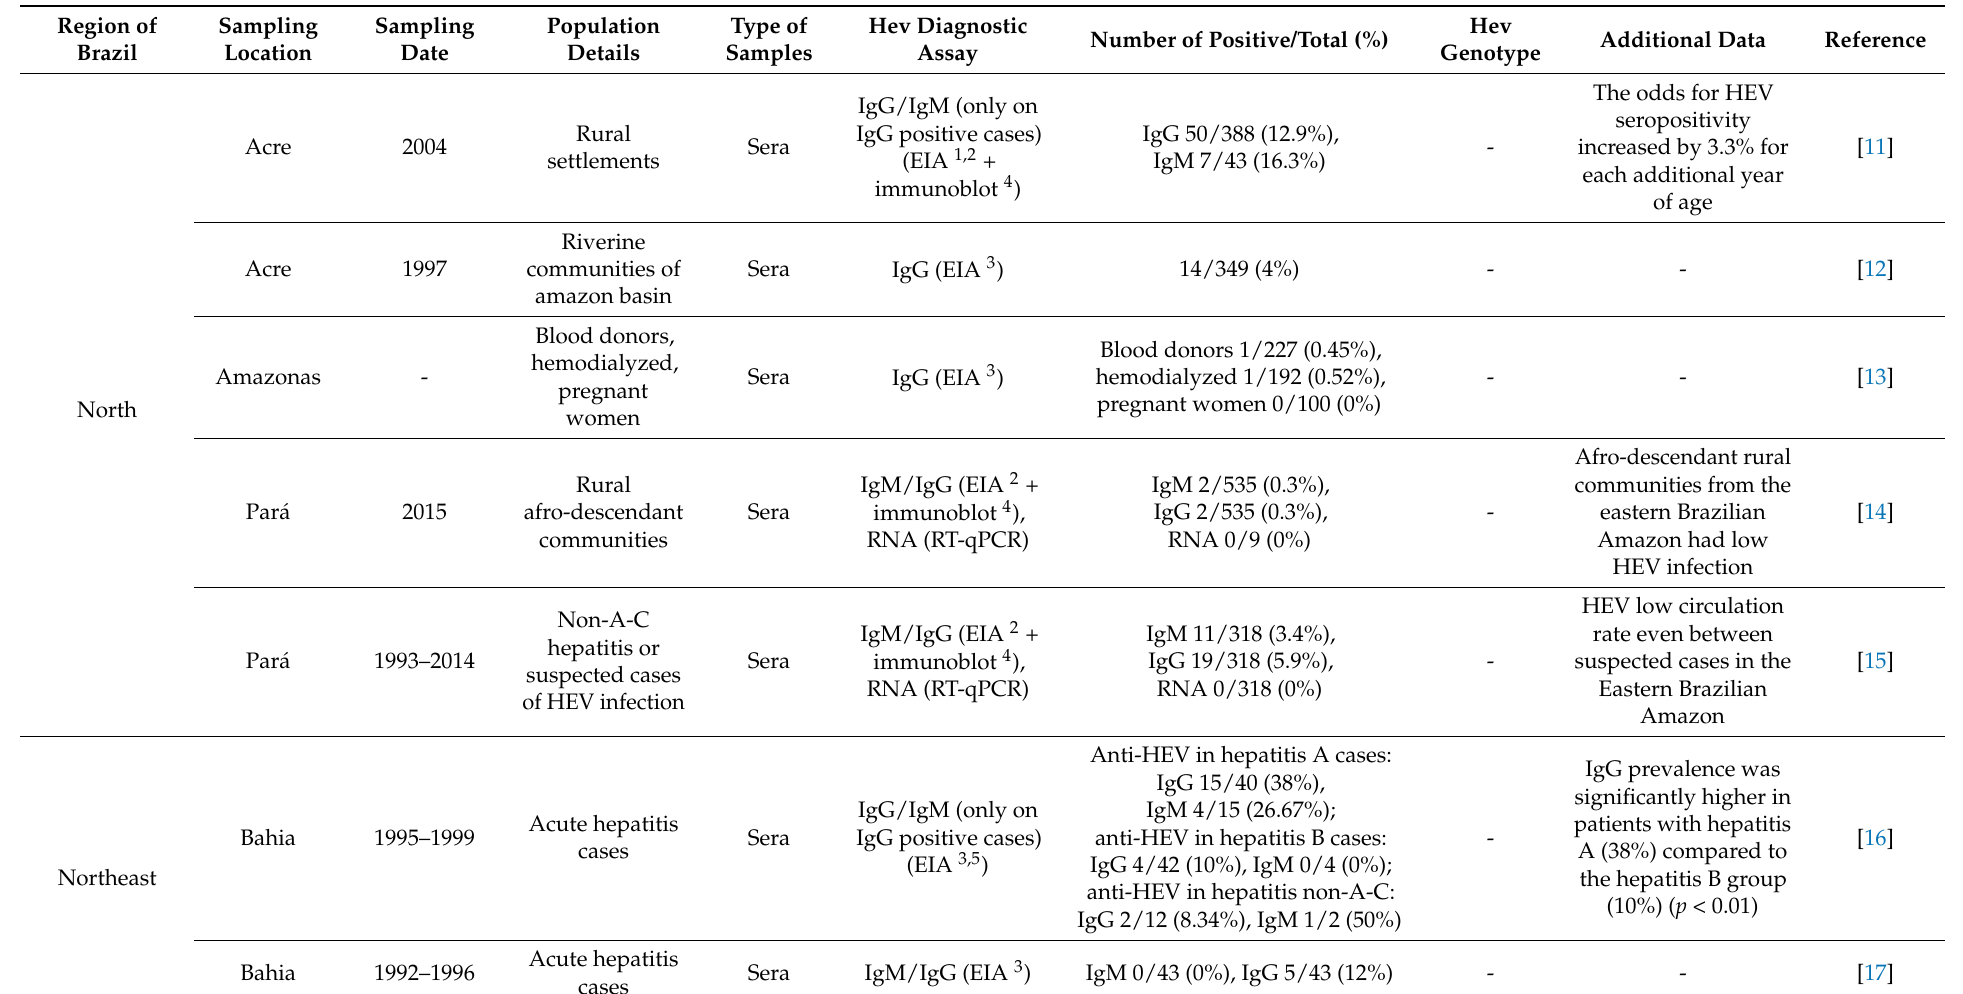
Table 1. HEV in humans,